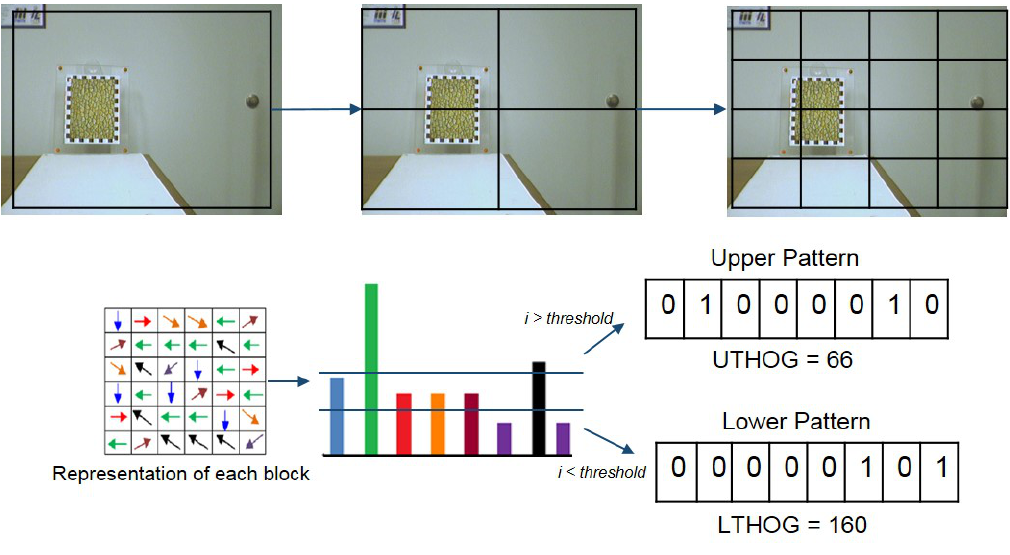
Figure 3. Proposed feature descriptor, Pyramid Ternary Histogram of Oriented Gradient